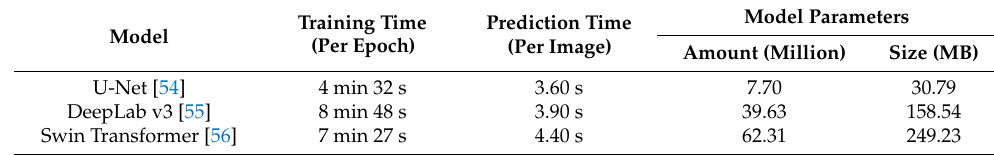
Table 3. Number of model parameters and time